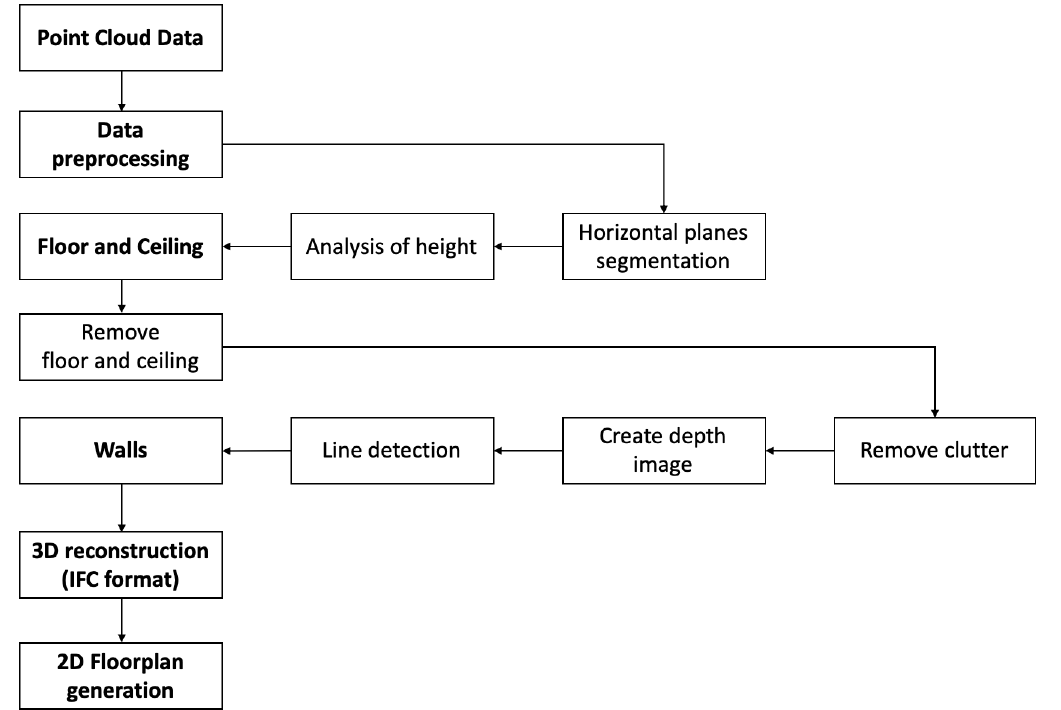
Figure 1. Overview of the proposed method that automatically creates a 2D floorplan CAD from unstructured 3D point